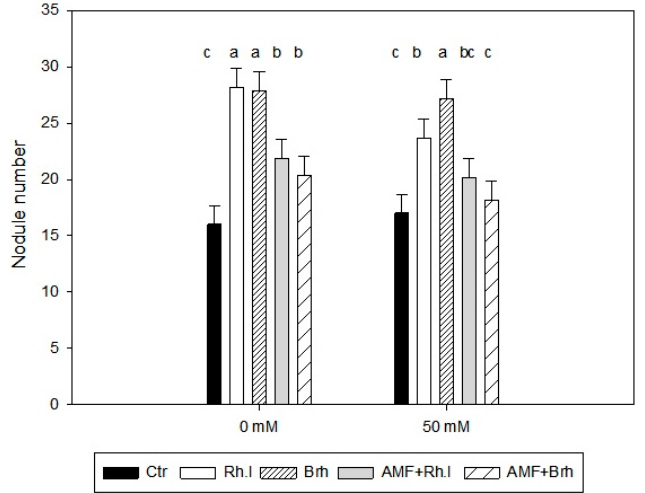
Figure 1. Average number of nodules per plant in control (Ctr), Rhizobium leguminosarum -inoculated (Rh.l), Burkholderia sp.-inoculated (Brh), Rhizophagus irregularis + Claroideoglomus claroideum + Rhizobium leguminosarum -inoculated (AMF + Rhl) and Rhizophagus irregularis + Claroideoglomus claroideum + Burkholderia spp.-inoculated (AMF + Brh) pea plants under two levels of salinity (0 and 50 mM NaCl). Different letters indicate significant differences within following parameters (Tukey test, p < 0.05; mean ± SD).